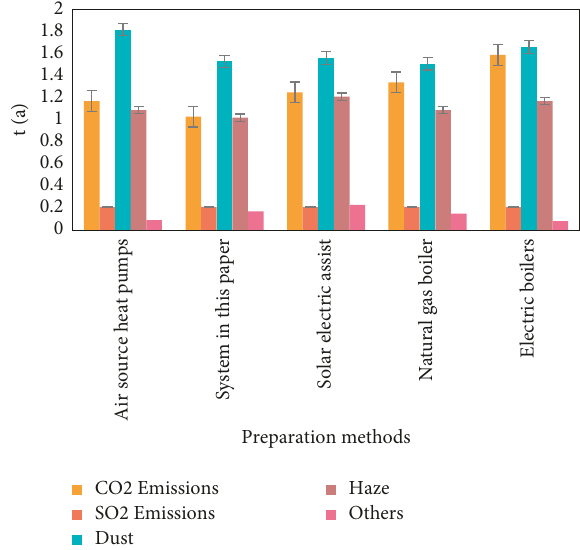
Figure 6: Environmental benefits of different preparation